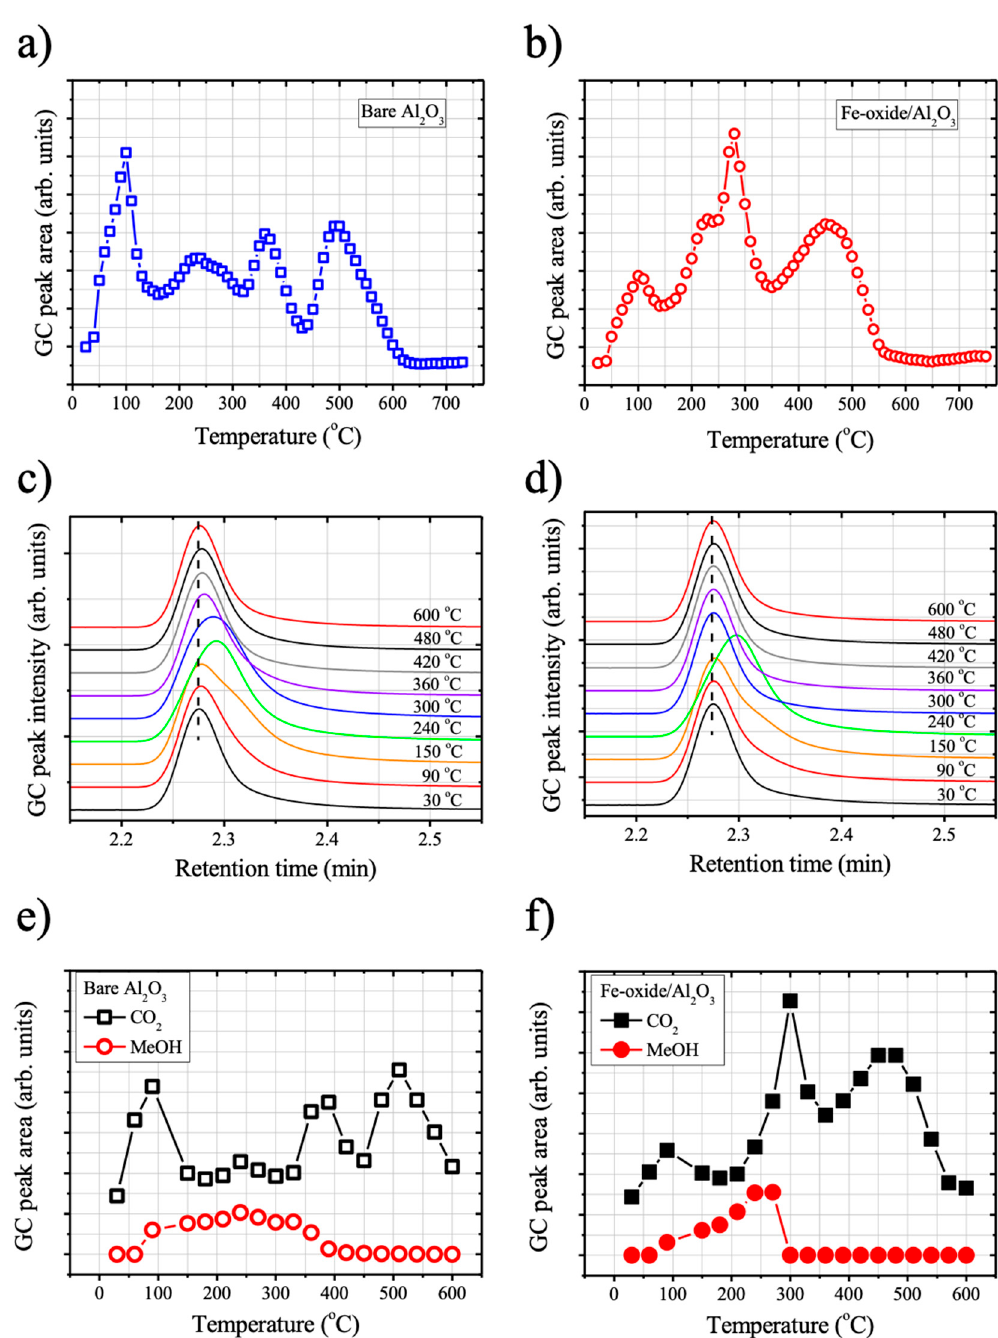
Figure 6. Gas chromatography (GC) peak area of Temperature Programmed Oxidation (TPO) experiments are displayed as a function of temperature for either case of ( a ) bare Al 2 O 3 or ( b ) Fe-oxide / Al 2 O 3 . GC peaks of TPO experiments measured at various temperatures are displayed for either case of ( c ) bare Al 2 O 3 or ( d ) Fe-oxide / Al 2 O 3 . The peak height of each GC peak was normalized to that of the respective GC peak obtained with each sample at 30 ◦ C and the normalized GC spectra were vertically shifted for comparison. Deconvolution results of the GC peaks of TPO at various temperatures are displayed as a function of temperature of TPO experiments for the case of ( e ) bare Al 2 O 3 and ( f ) Fe-oxide / Al 2 O 3 . The y -axis values of graphs in left- and right- column are displayed in same Y -axis scale, thus the GC peak area values between bare Al 2 O 3 and Fe-oxide / Al 2 O 3 can be directly compared.